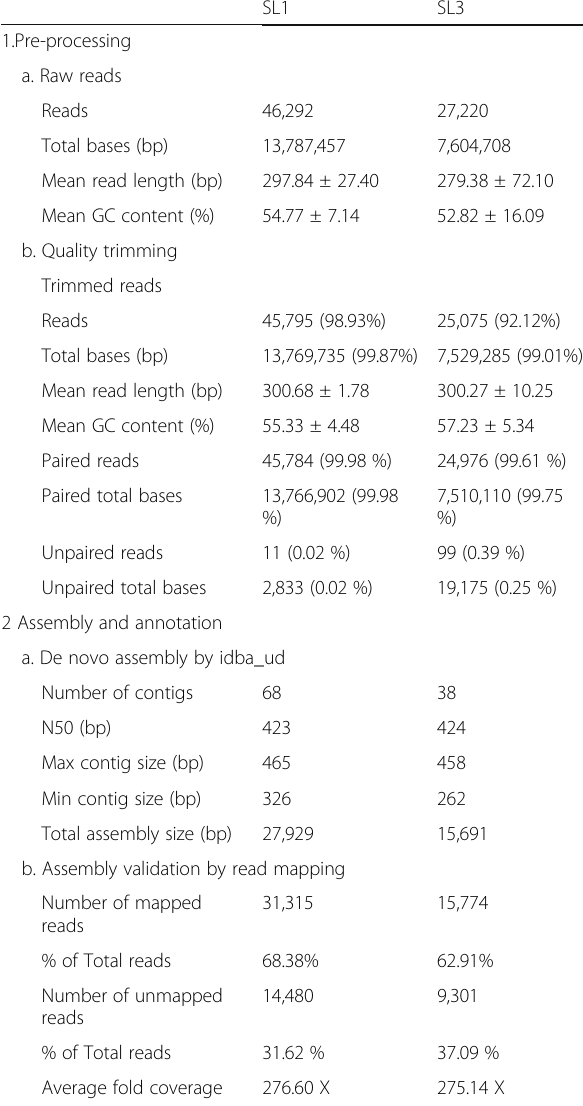
Table 2 General features of SL1 and SL3 metagenomes SL1